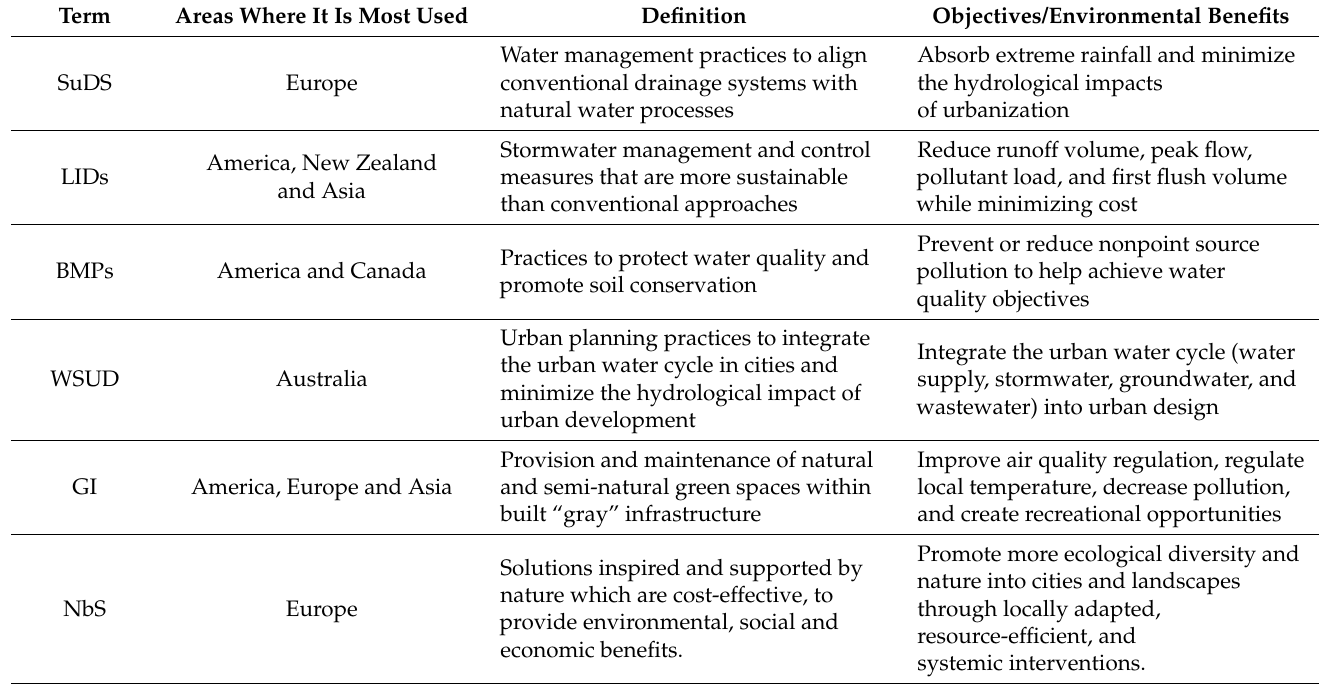
Table 1. Urban practices to mitigate soil sealing; terms, definitions, and objectives [13,15,16,35,38,41,